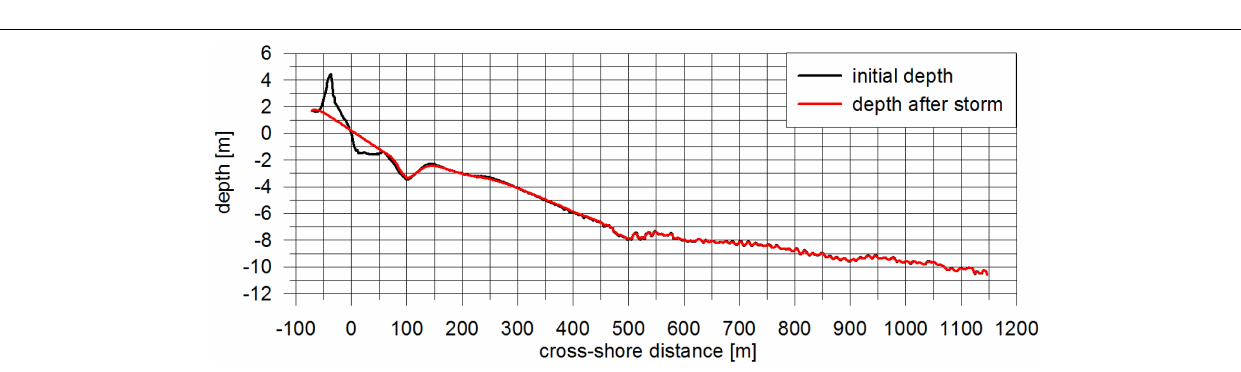
Frontiers in Marine Science |